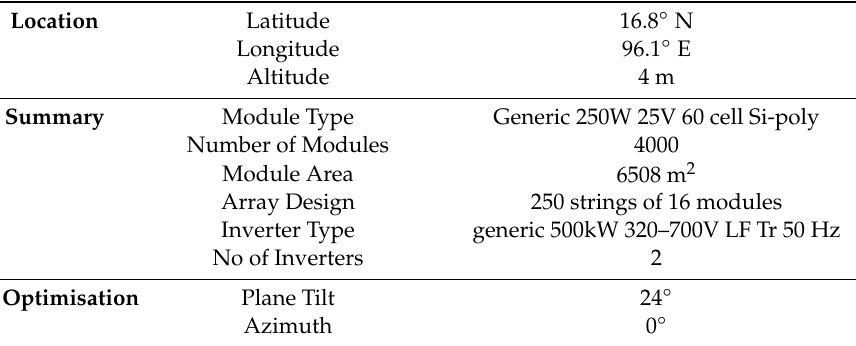
Table 4. Photovoltaic (PV) installation